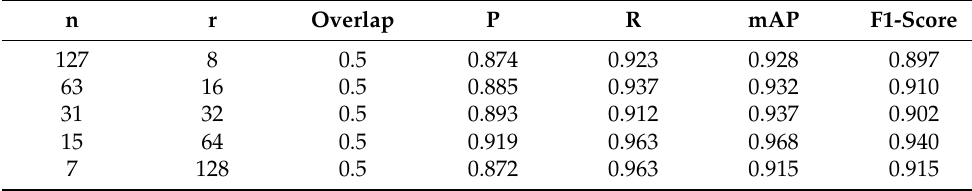
Table 3. Different preset slice length factor.